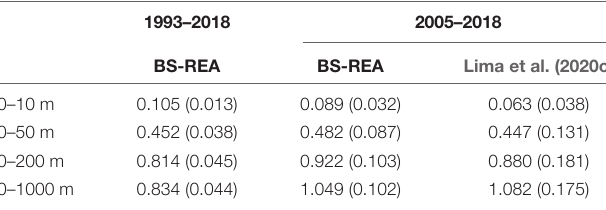
TABLE 3 | Trends estimations together with the 95% confidence interval (in brackets) for the ocean heat content anomaly (W m − 2 ) from BS-REA and